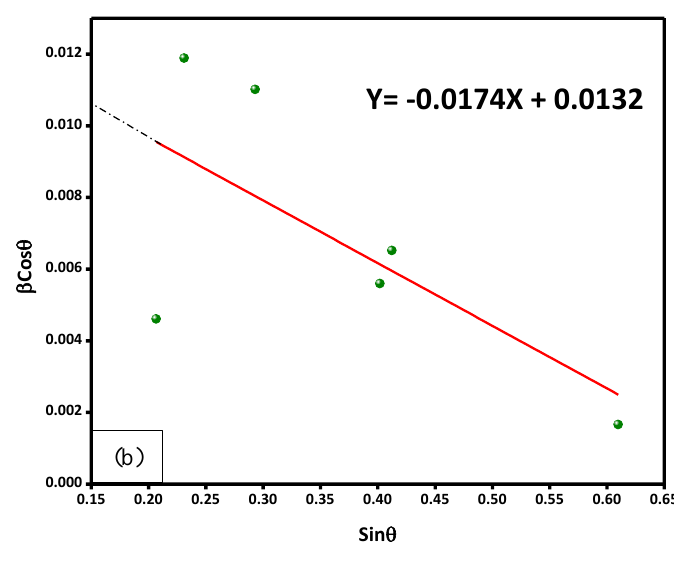
Figure 4. (a) X-Ray Diffraction of 45S5 Bioactive Glass; (b) W-H Plot